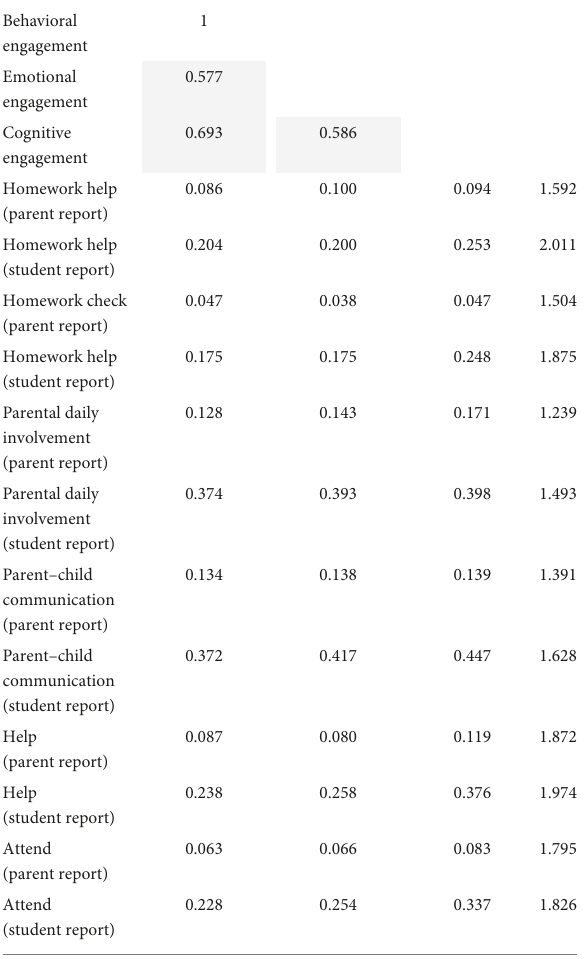
TABLE 3 Correlations between parental involvement variables and student school